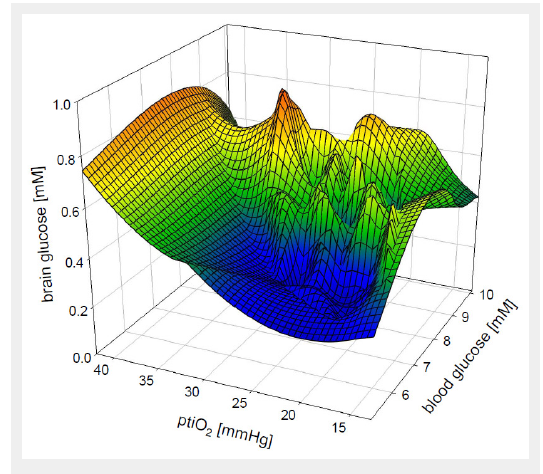
Three- dimensional graph showing functional impact of blood glucose and cerebral perfusion (indirectly assessed by ptiO 2 ) on brain glucose. While low blood glucose can be compensated by a higher level of cerebral perfusion (higher ptiO 2 values) to increase brain glucose levels, elevated blood glucose can compensate for lower level of cerebral perfusion (lower ptiO 2 values). Optimal conditions unmasked by highest brain glucose levels appear to be at arterial blood glucose values between 8 and 9 mmol/l and ptiO 2 values around 30 mm